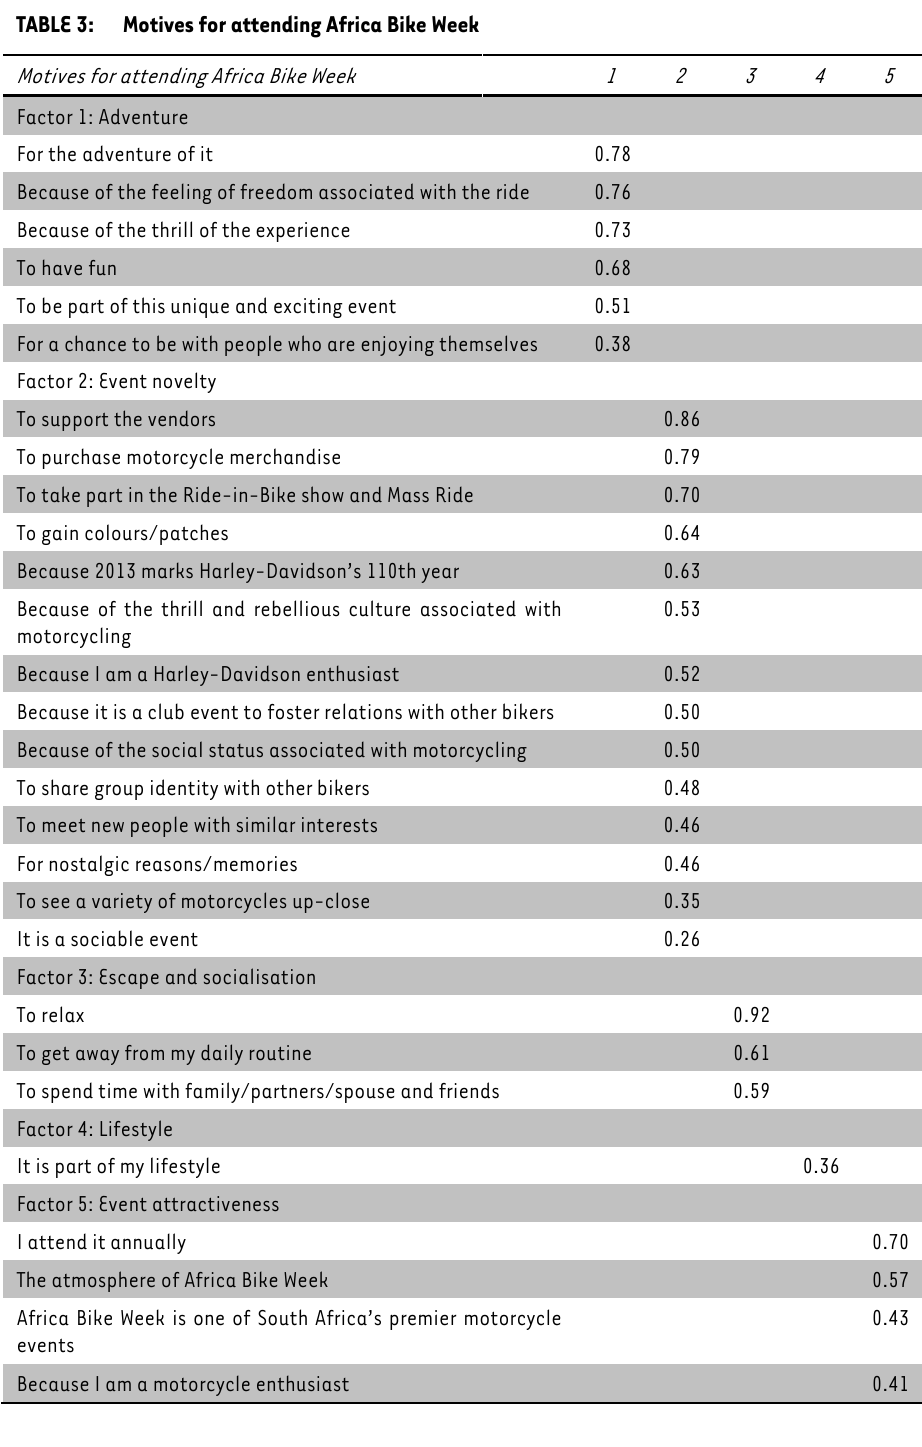
WHO ARE THE BIG SPENDERS AT A MOTORCYCLE EVENT?